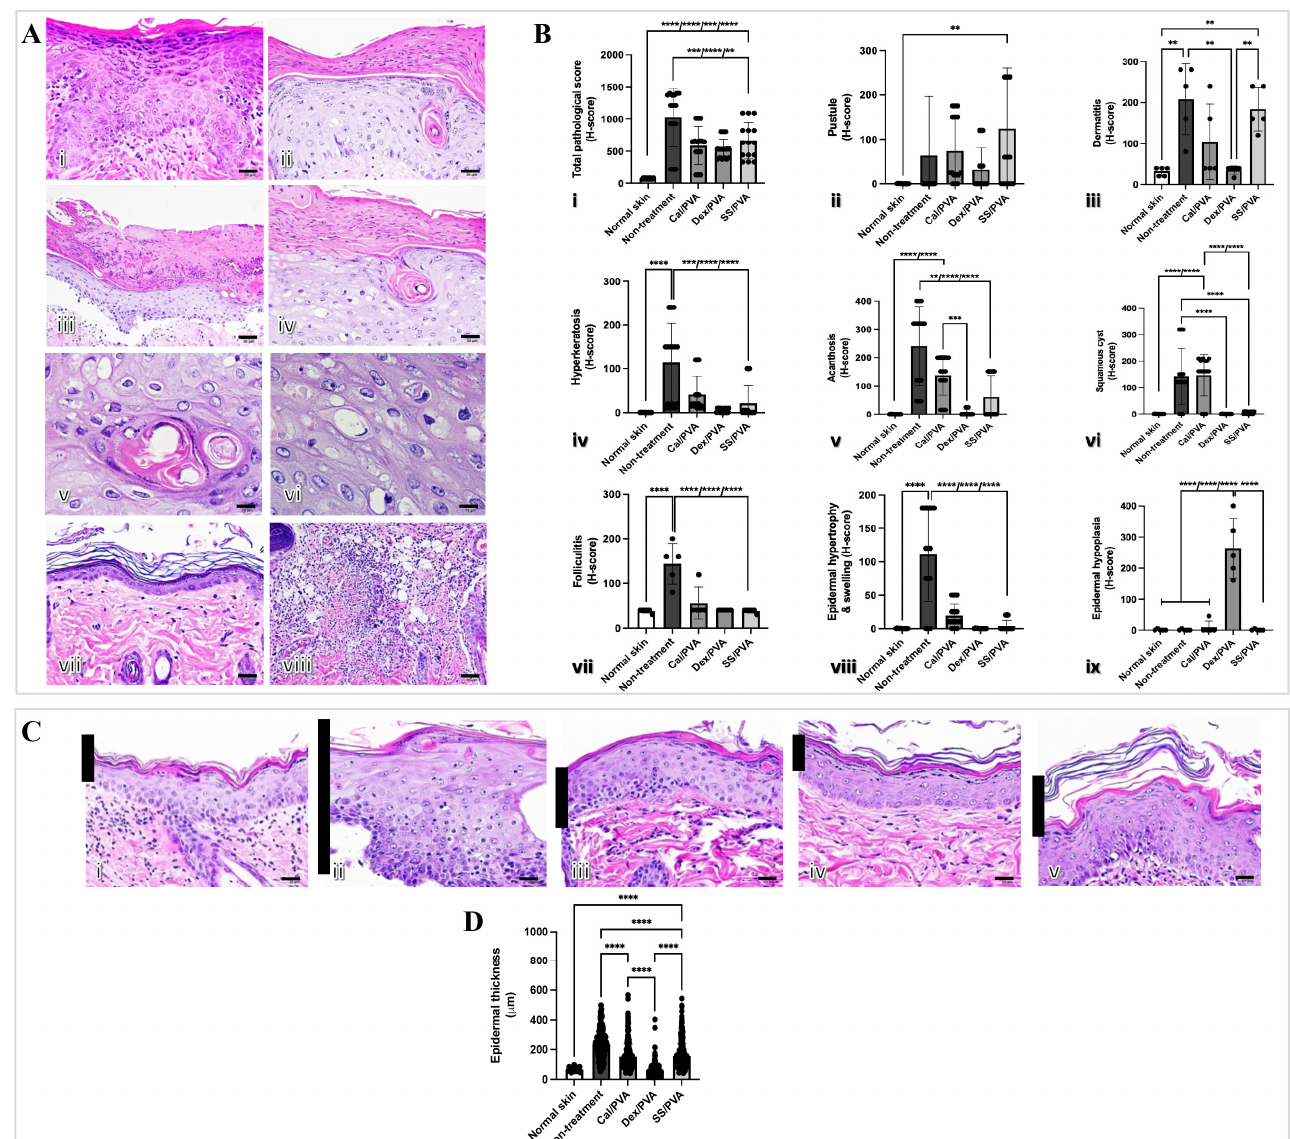
Figure 3. Epidermal thickness and histopathological evaluation of imiquimod-induced psoriatic rat skins after treatment. ( A ) Histological appearances in imiquimod-induced psoriatic rats after 7 days of induction ( i – viii ) : ( i ) acanthosis; ( ii ) hyperkeratosis; ( iii ) pustules; ( iv ) epidermal hypertrophy with cysts; ( v ) squamous cyst ( high magnification ); ( vi ) epidermal hypertrophy ( high magnifica- tion ); ( vii ) epidermal hypoplasia; ( viii ) folliculitis with dermatitis. ( B ) Bar graph of pathological scores involving psoriasis derived using ANOVA ( i – ix ): ( i ) total pathological score; ( ii ) pustules; ( iii ) dermatitis; ( iv ) hyperkeratosis; ( v ) acanthosis; ( vi ) squamous cysts; ( vii ) folliculitis; ( viii ) epi- dermal hypertrophy and swelling; ( ix ) epidermal hypoplasia. ( C ) Epidermal thickness stained with hematoxylin and eosin ( H&E ) on Day 7 of post-treatment in the psoriatic skin of rats ( i – v ) at 400 × magnification: ( i ) normal skin; ( ii ) no treatment; ( iii ) calcitriol; ( iv ) dexamethasone; ( v ) sericin. ( D ) Bar graph of total epidermal thickness derived using ANOVA. Scale bars ( Ai – iv , vii , viii , Ci – v ) = 20 μ m, ( Av , vi ) = 10 μ m. The significant level in the figure was presented as ** = p < 0.01, *** = p < 0.001, **** = p < 0.0001 .